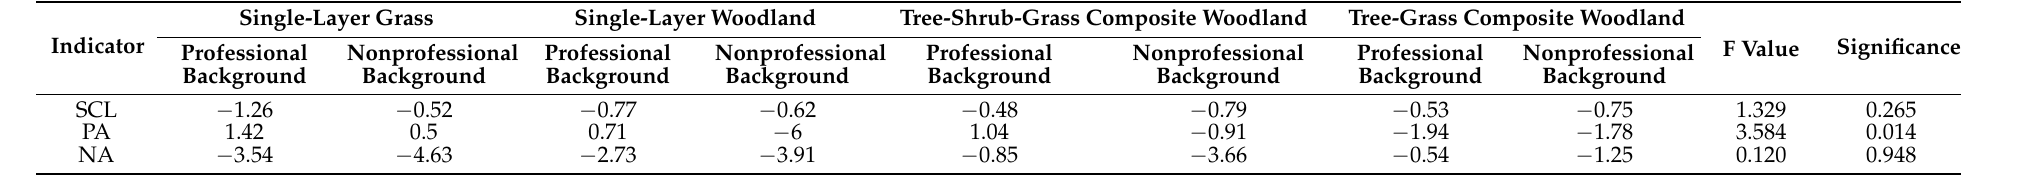
Table 5. Effects of professional background and plant community type on physiological and psychological